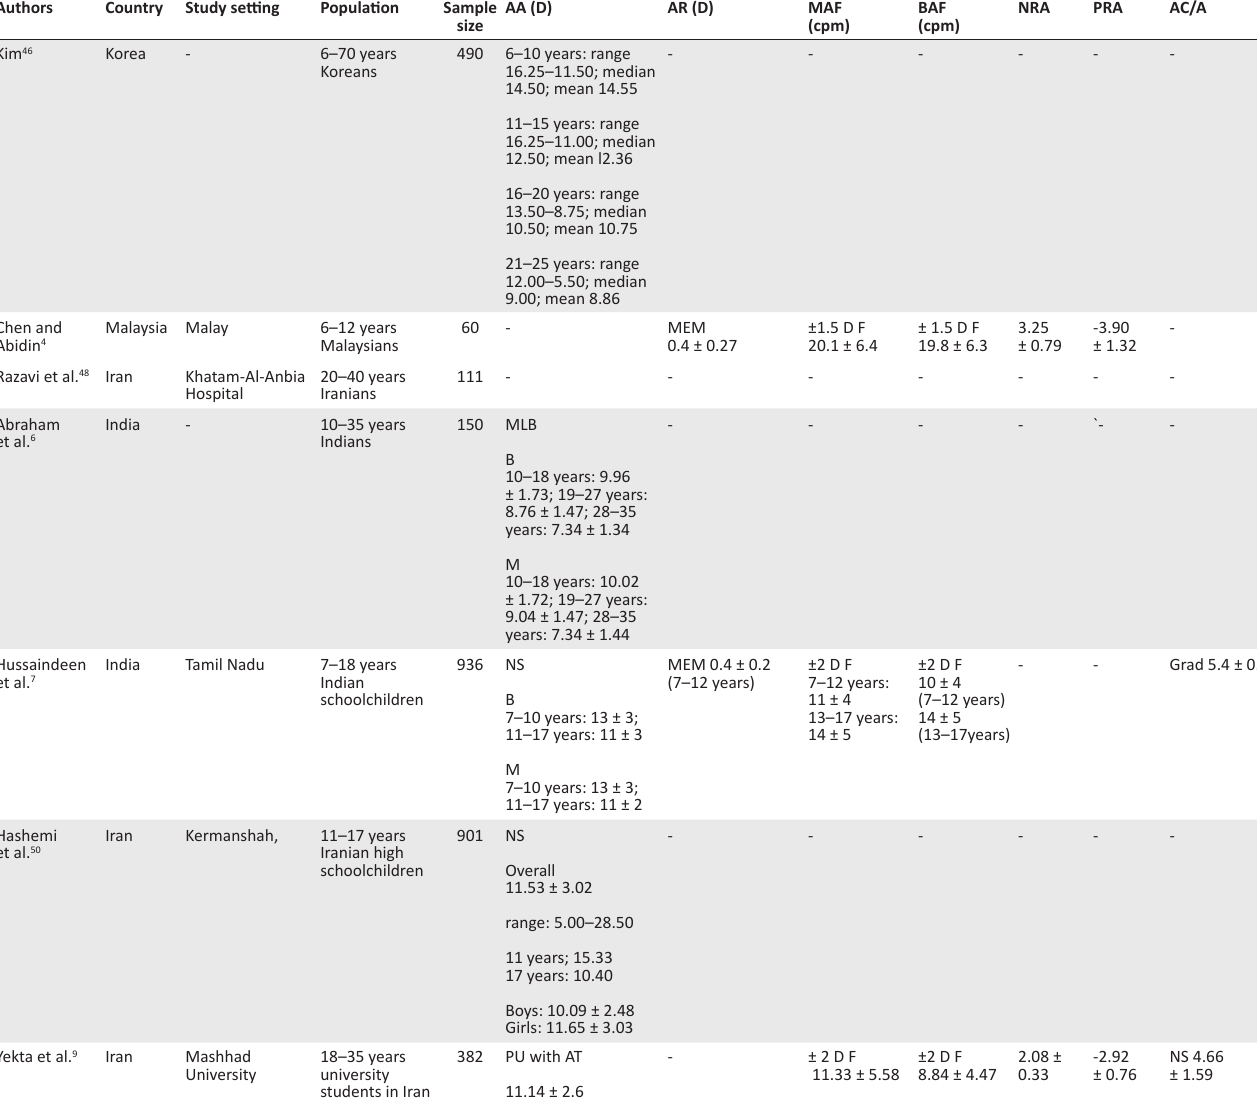
TABLE 6: Normative data for accommodative parameters in